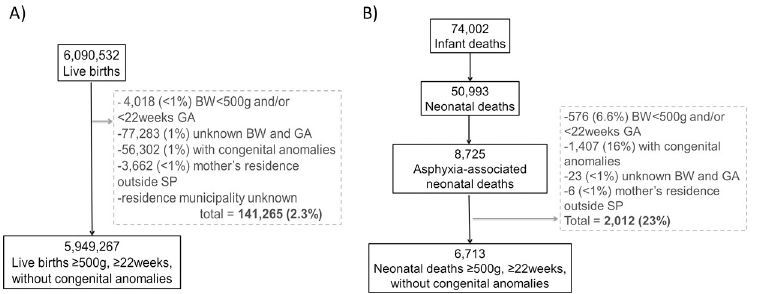
Fig 1. Flowchart of included population–S ã o Paulo State (Brazil), from 2004 to 2013. A) Live births; B) Deaths. BW: birth weight, GA: gestational age, SP: S ã o Paulo State.